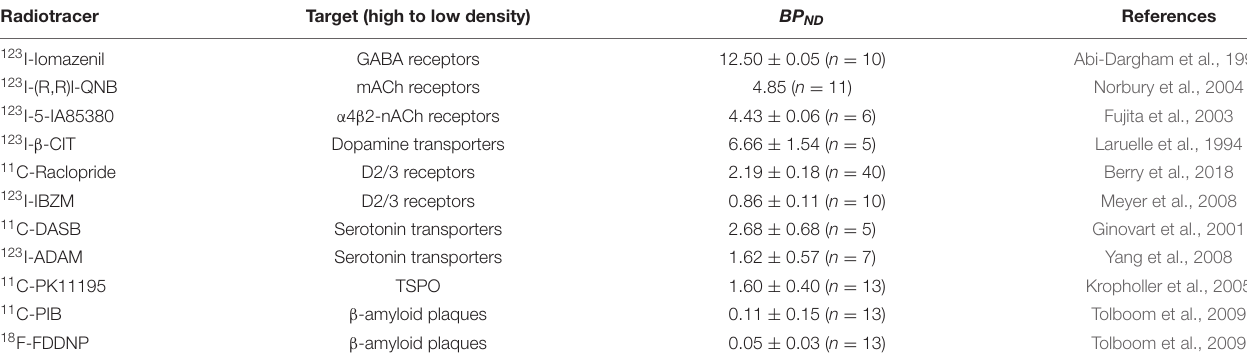
TABLE 1 | Examples of brain SPECT and PET radiotracers previously developed and associated BP ND values in healthy humans.